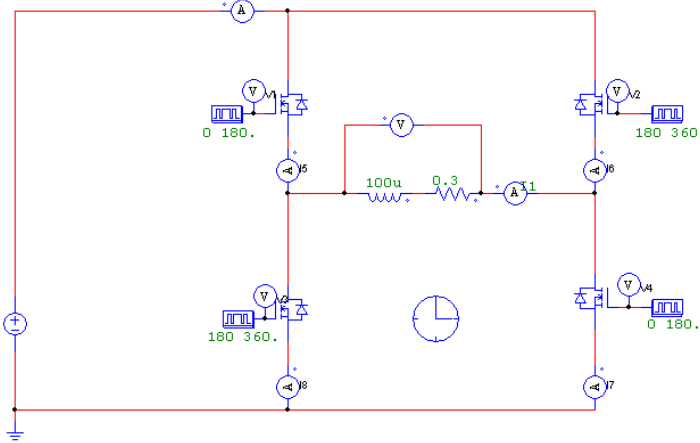
Figure 3. Simulation model of traditional full bridge circuit.